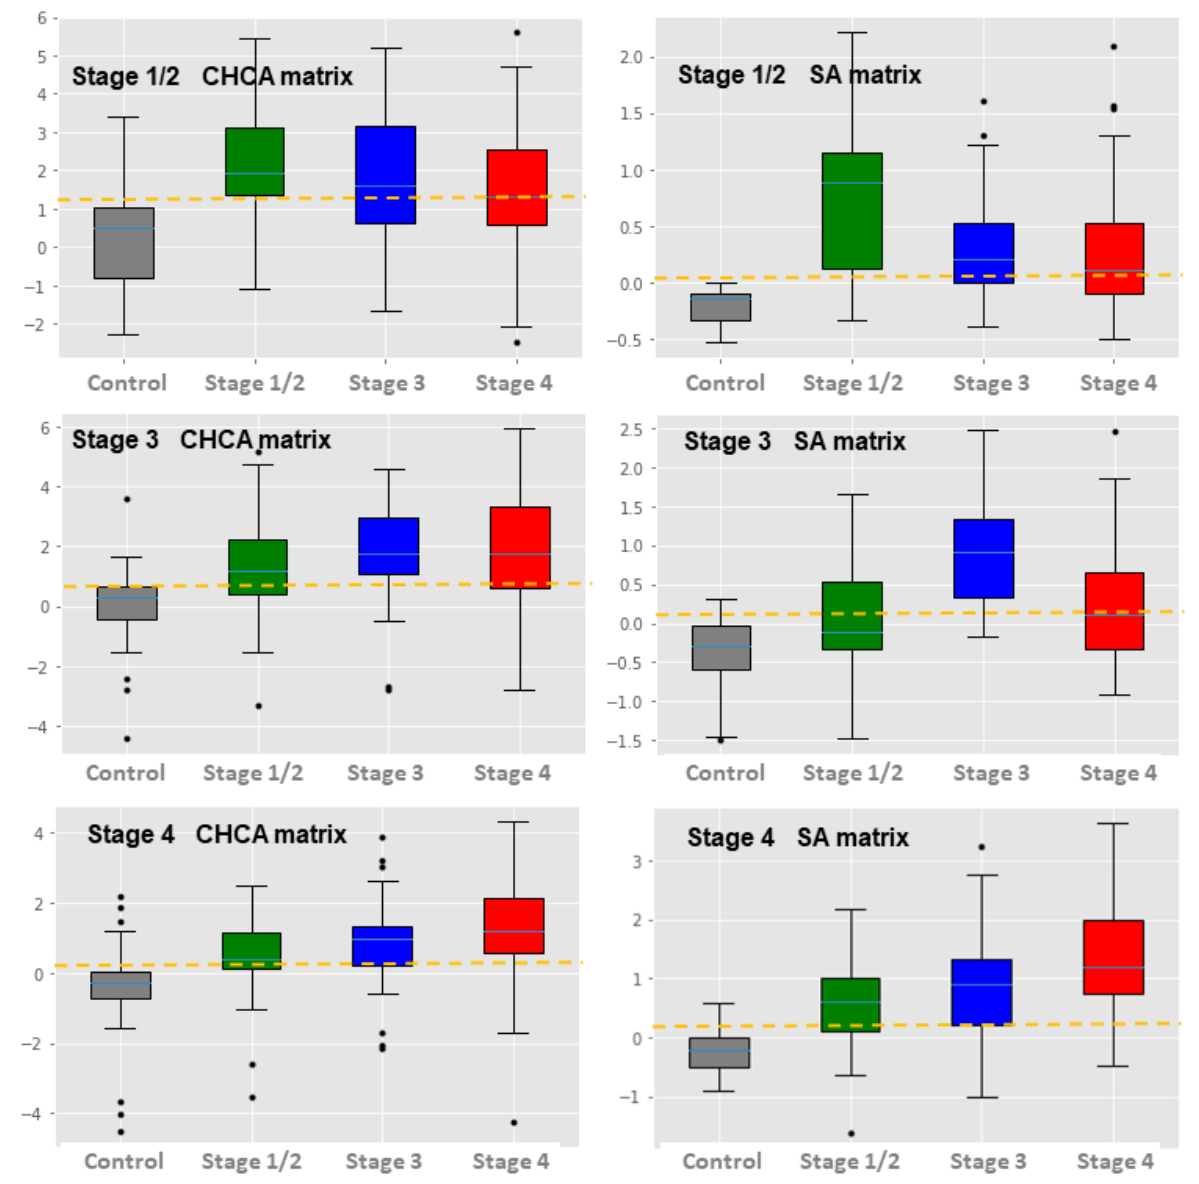
Figure 6. Stage-specific scores of serum mass spectra using each algorithm. Each panel corresponds to the scores using a classification model specifically designed for a particular cancer stage and using a given matrix type (indicated within a panel). Each box represents scores of mass spectral data of distinct groups (Control, Stage 1/2, Stage 3, and Stage 4) and, respectively, depicted with different colors (grey, green, blue, and red). The classification cutoffs obtained through machine learning for each model are depicted by the orange dashed lines. Medians are indicated as blue lines; whiskers represent 95% of distribution and black dots the outliers.